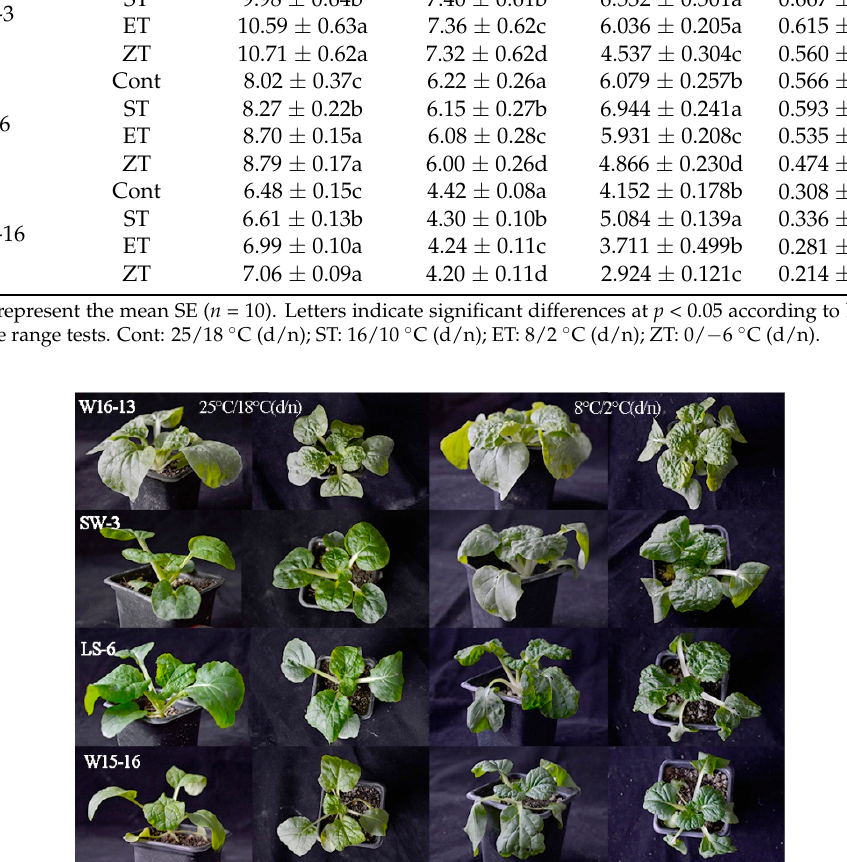
Figure9. Effects of cold stress on ( A ) Chl a , ( B ) Chl b , ( C ) Chl a+b , ( D ) Car in four wucai genotypes. Values represent the mean SE ( n = 3). Values with the same letter are not significantly different at the p < 0.05. Cont: 25/18 °C (d/n); ST: 16/10 °C (d/n); ET: 8/2 °C (d/n); ZT: 0/ − 6 °C (d/n). 3.4. OJIP Curves of Cold Stress